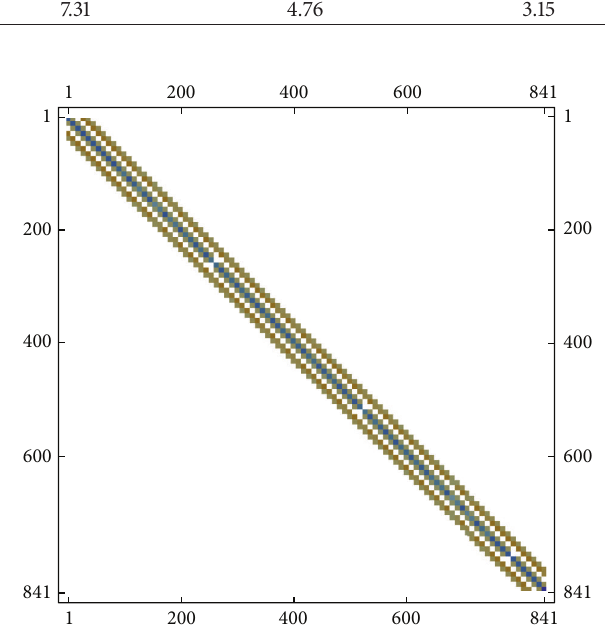
Figure 4: The plot of matrix 𝐴 in Experiment 3.